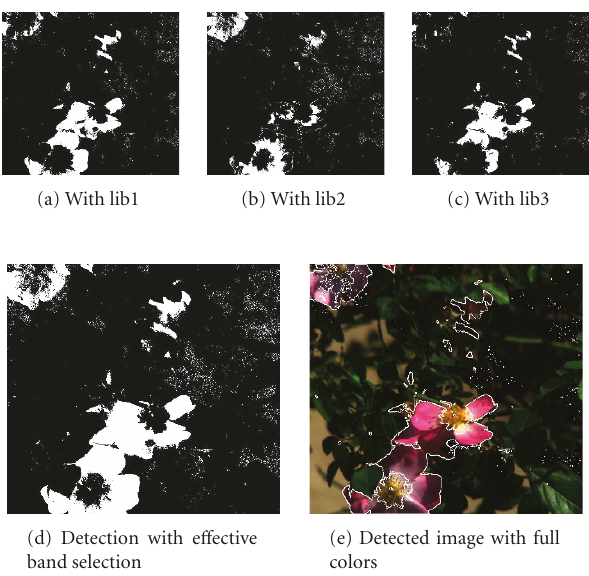
Figure 14: Result of detected image when e ff ective band selection strategy is used in the detection.